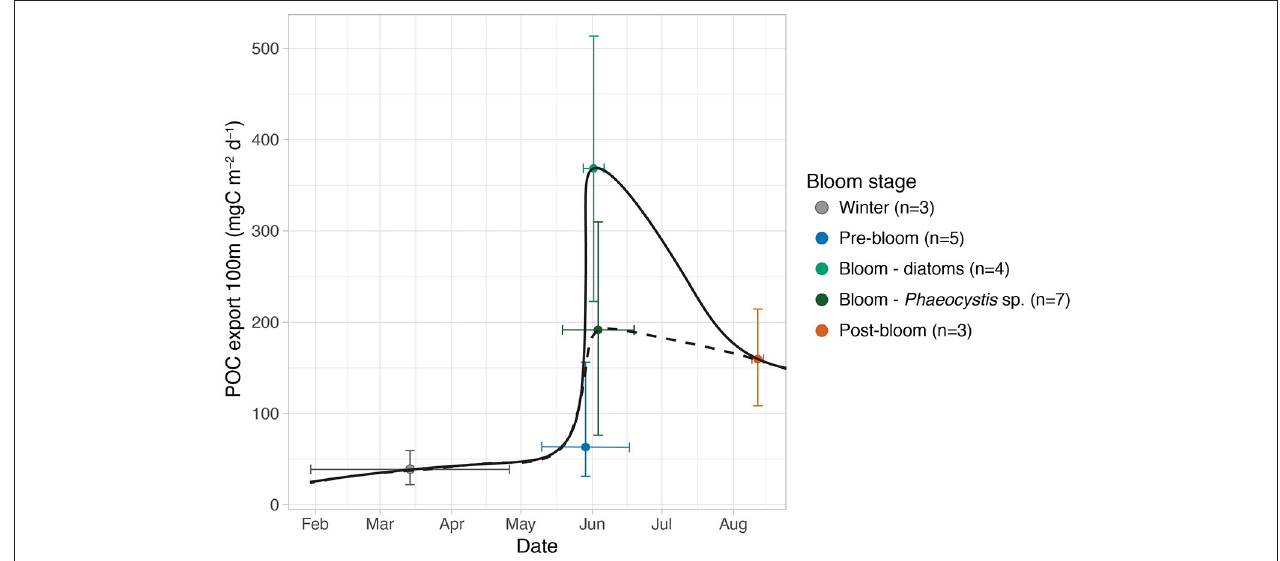
FIGURE 9 | General seasonal progression of vertical POC export fluxes at 100m in the region north of Svalbard (mean mg POC m − 2 day − 1 , + /– full range). The export fluxes are separated into bloom conditions and dominant phytoplankton groups during the blooms (n, number of measurements). Black lines: rough visual interpolation of seasonal trend using diatoms (solid) and Phaeocystis (dashed)